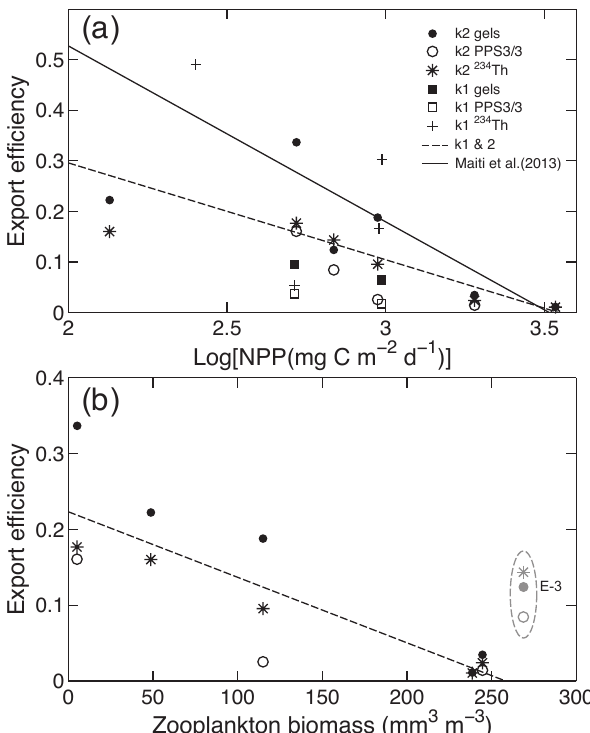
Figure 9. Relationships between net primary productivity (a) , zoo- plankton biomass (b) and export efficiency calculated using partic- ulate organic carbon fluxes estimated at 200 ± 10m from PPS3/3 traps, gel traps and 234 Th methods for the KEOPS2 (k2) and KEOPS1 (k1, (a) only) studies. (a) The black line represents the em- pirical relationship from Maiti et al. (2013) estimated in the South- ern Ocean ( y = − 0 . 35 x + 1 . 22; r 2 = 0 . 97), and the dashed line rep- resents the regression line for all KEOPS data ( y = − 0 . 19 x + 0 . 68; n = 24, r 2 = 0 . 33, p < 0 . 005). (b) The dashed line represents the regression line for KEOPS2 data ( y = − 0 . 00086 x + 0 . 2232; n = 15, r 2 = 0 . 72, p < 0 . 0005). E-3 was assumed an outlier and was ex- cluded from the best fit calculation (see text for possible expla- nation). Panel (a) suggests that the most productive sites are the less efficient to export carbon. Panel (b) suggests that zooplankton biomass could influence the efficiency of carbon export by bypass- ing direct export via phytodetrital